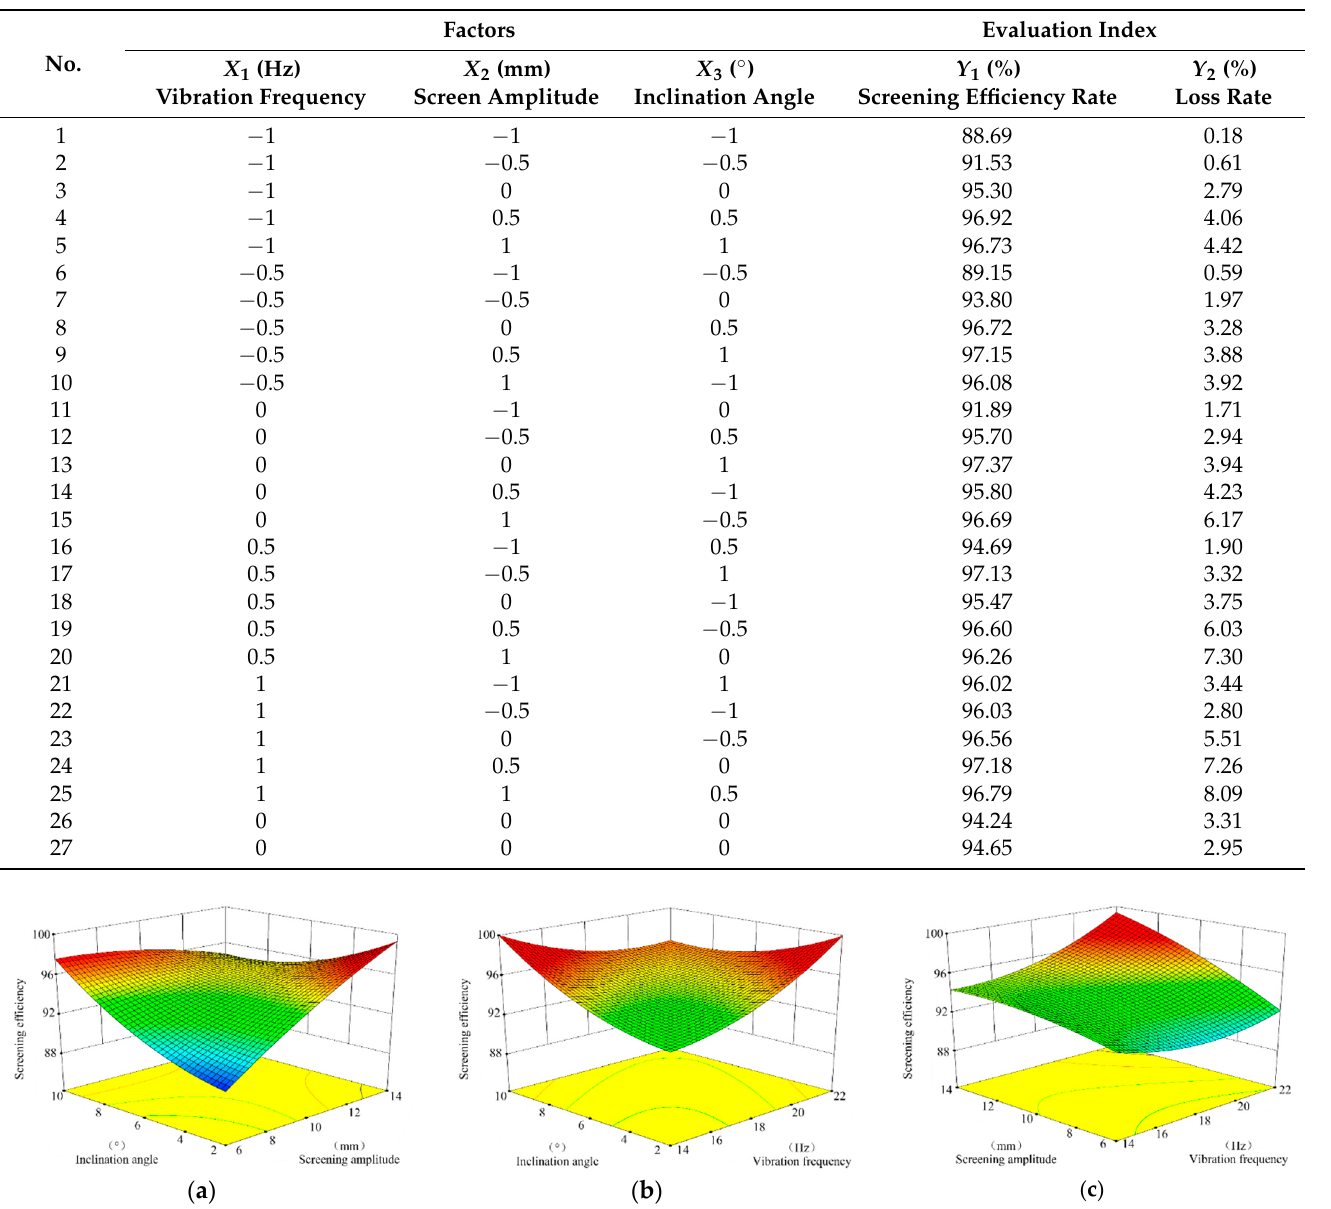
Table 4. Codes of experimental factors.